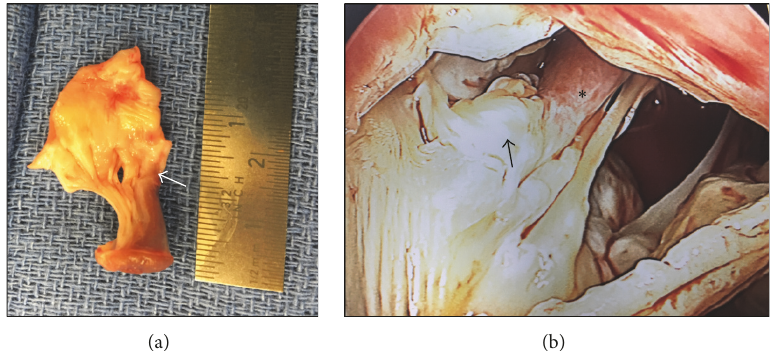
Figure 3: Gross pathology findings. (a) Specimen excised during surgery showing a hypertrophied anterolateral LV papillary muscle attached directly to the anterior mitral leaflet edge with minimal chordae present (white arrow). The anterior leaflet appears myxomatous. (b) In situ view of anomalous anterior papillary muscle (asterisk) insertion directly into anterior mitral leaflet (black arrow) which is more anteriorly displaced and extending across the